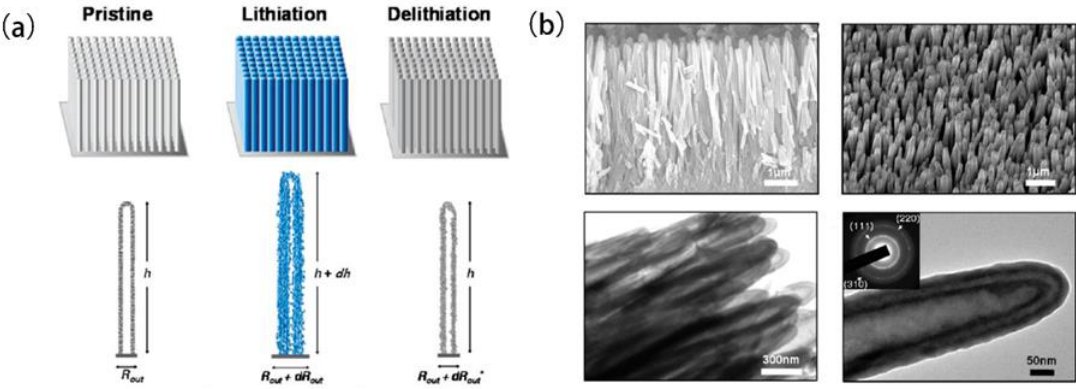
Figure 5. ( a ) 3D view of SiNT array anode material and simplified cross-section view before and after electrochemical cycling [28]. ( b ) TEM images of SiNT/Ge array [29]. Reprinted with permission from [28]. Copyright 2009 American Chemical Society. Reprinted with permission from [29]. Copyright 2012 American Chemical Society.